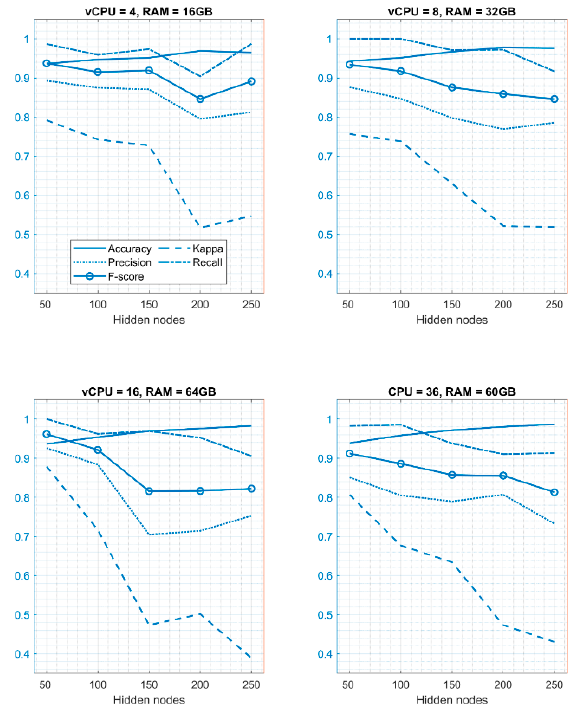
Figure 6. Graphical representation of the ELM model performance (cloud computing environment).